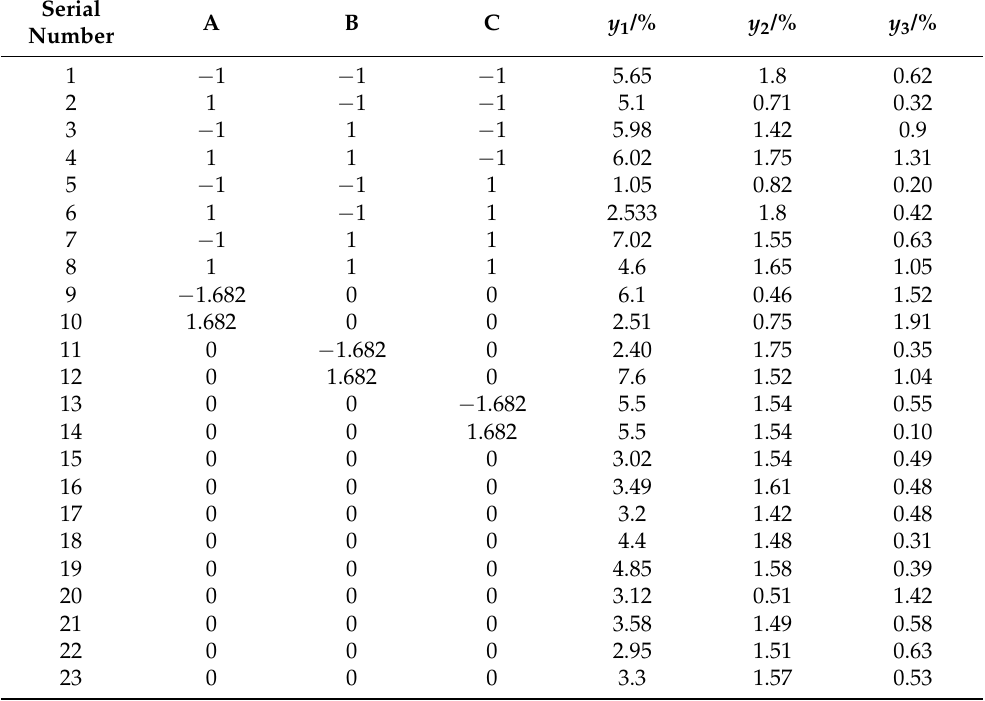
Table 3. Test scheme and